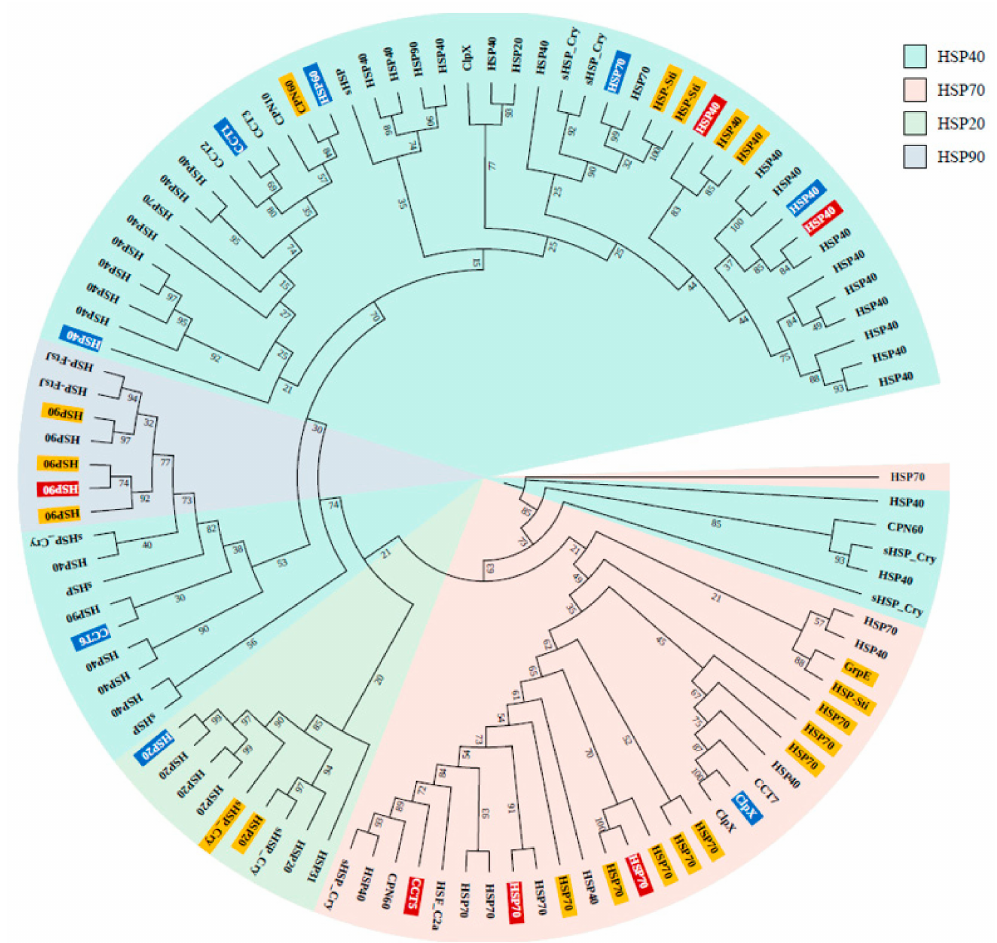
Figure 3. Phylogenetic tree of 102 HSPs annotated using ortholog and clustering methods (ir-HSP annotated proteins are not included). The tree was reconstructed from 1000 bootstrap replicates (bootstrap values included in their respective branches). The highlighting colors indicate HSPs selected for qRT-PCR (blue), di ff erentially expressed HSPs (yellow), and di ff erentially expressed HSPs selected for qRT-PCR